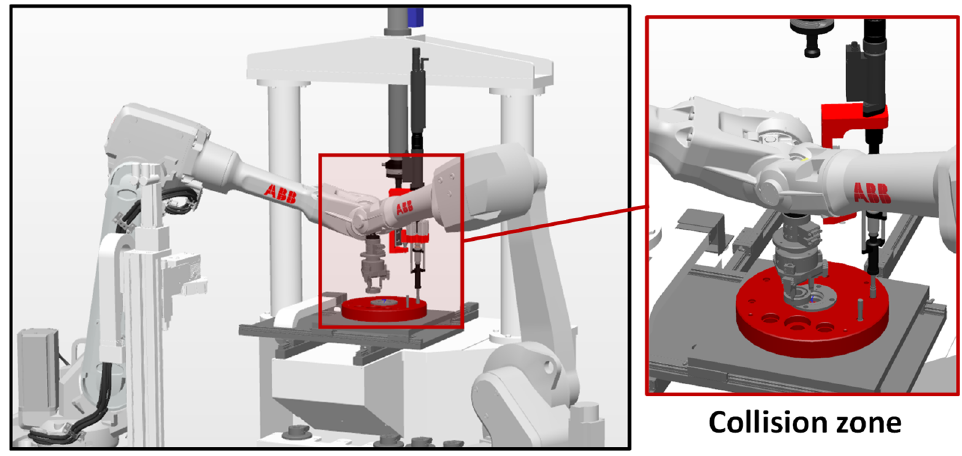
Figure 10. The sharing of the workspace of the two robots makes it essential to study the appropriate sequences of actions in a virtual environment to avoid collisions. In the figure, Robot 2 locating a bearing, collides with Robot 1 while it is screwing a stud.